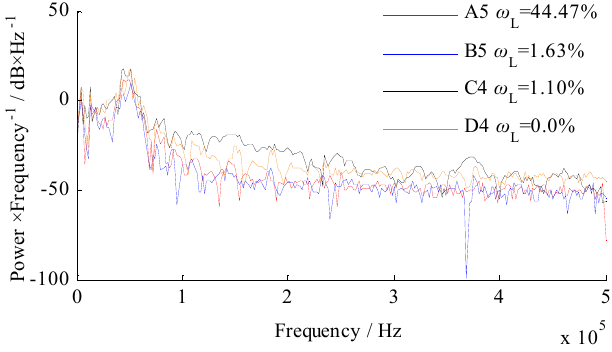
Figure 8. Initial power spectral density of specimens with different moisture contents.